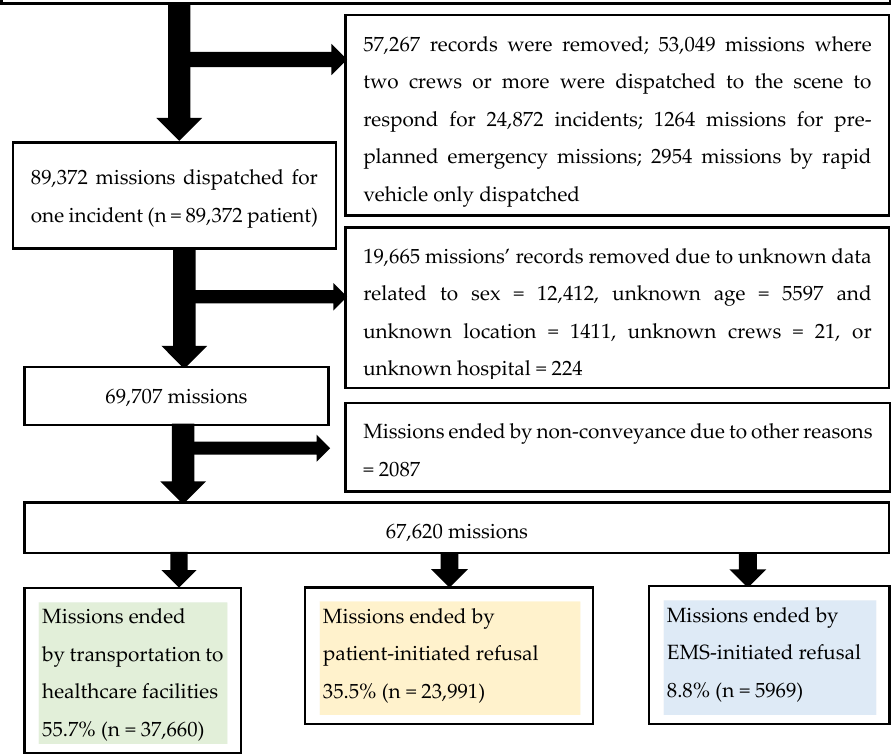
Figure 1. Flow chart of included and excluded missions that ended with the three outcomes.